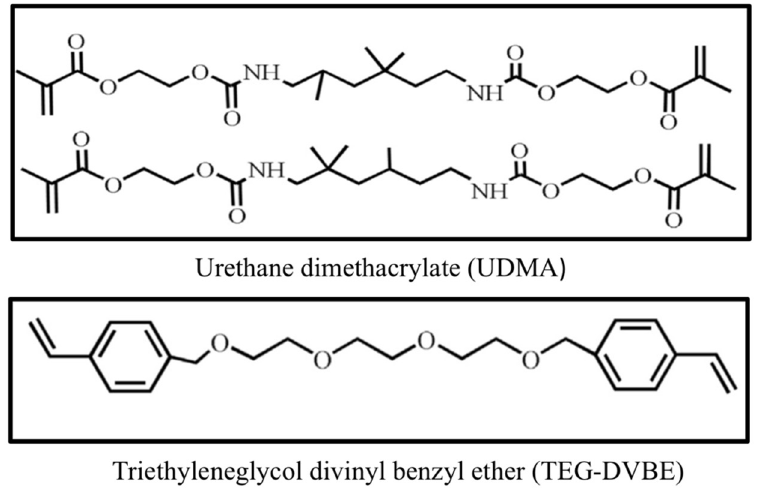
Figure 3. Chemical structure of the resins used in hydrolytically stable, low-shrinkage-stress com-